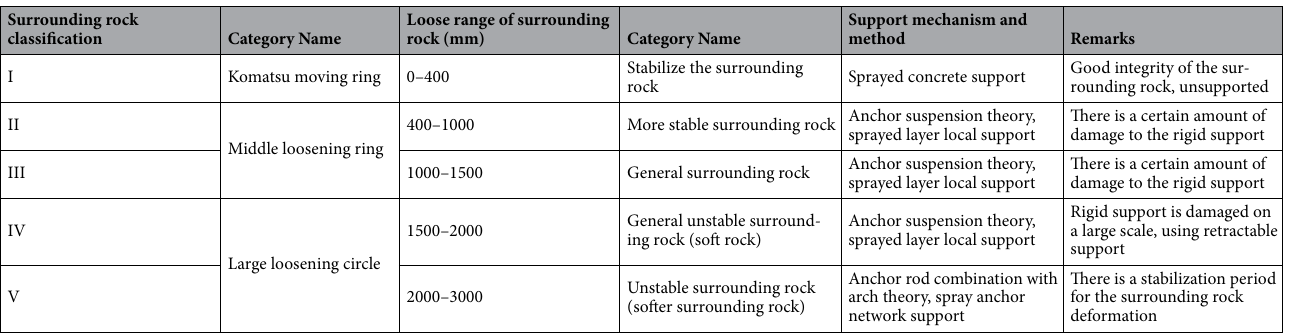
Table 1. Classification index of the surrounding rock loose zone.